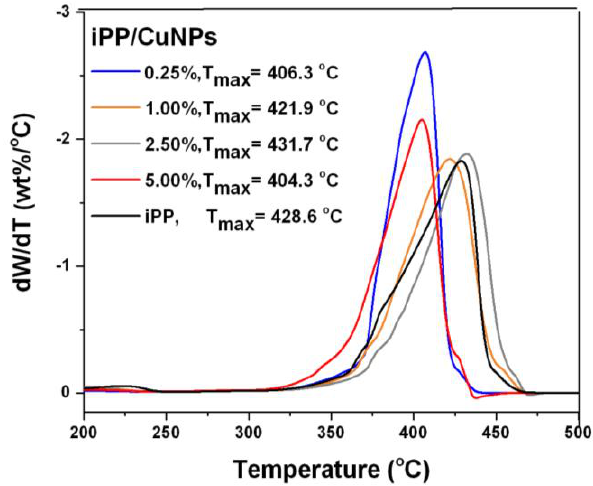
Figure 4. DTG curves of iPP and CuNPs/iPP composites.